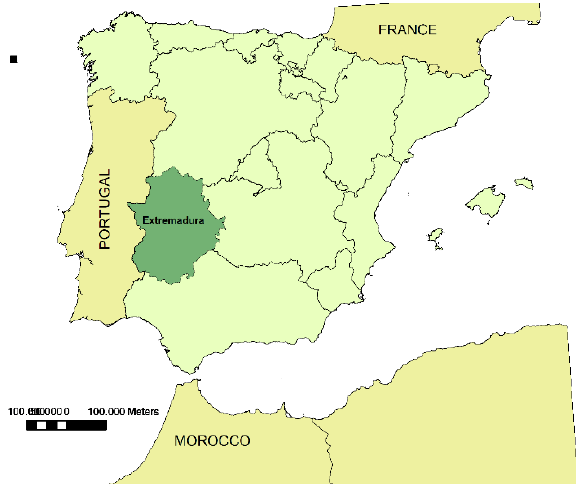
Figure 1. Location of area of study. Source: own elaboration. Table 1. Accommodation establishments and restaurants in Monfragüe National